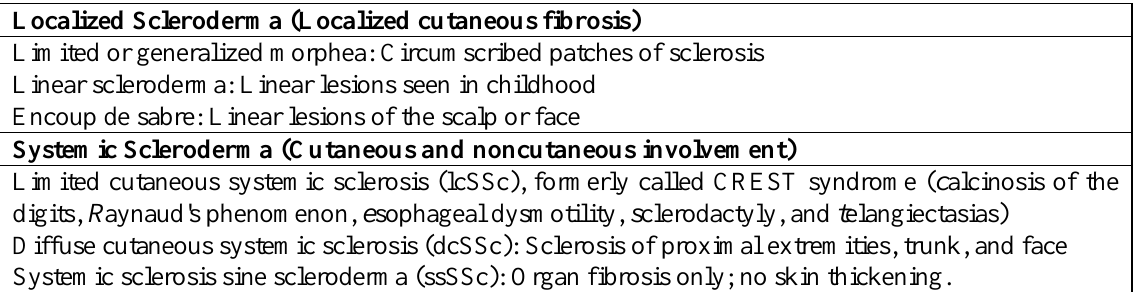
Table 1: Classification of Scleroderma (6)